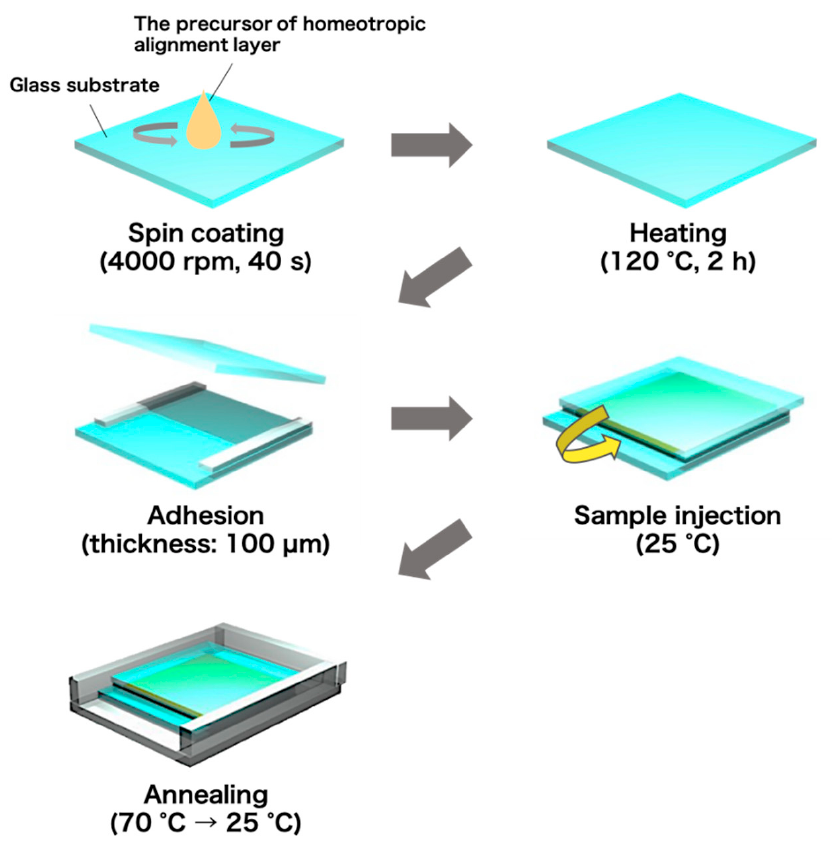
Figure 2. Preparation procedure for homeotropic-aligned oligothiophene-doped LC cells.